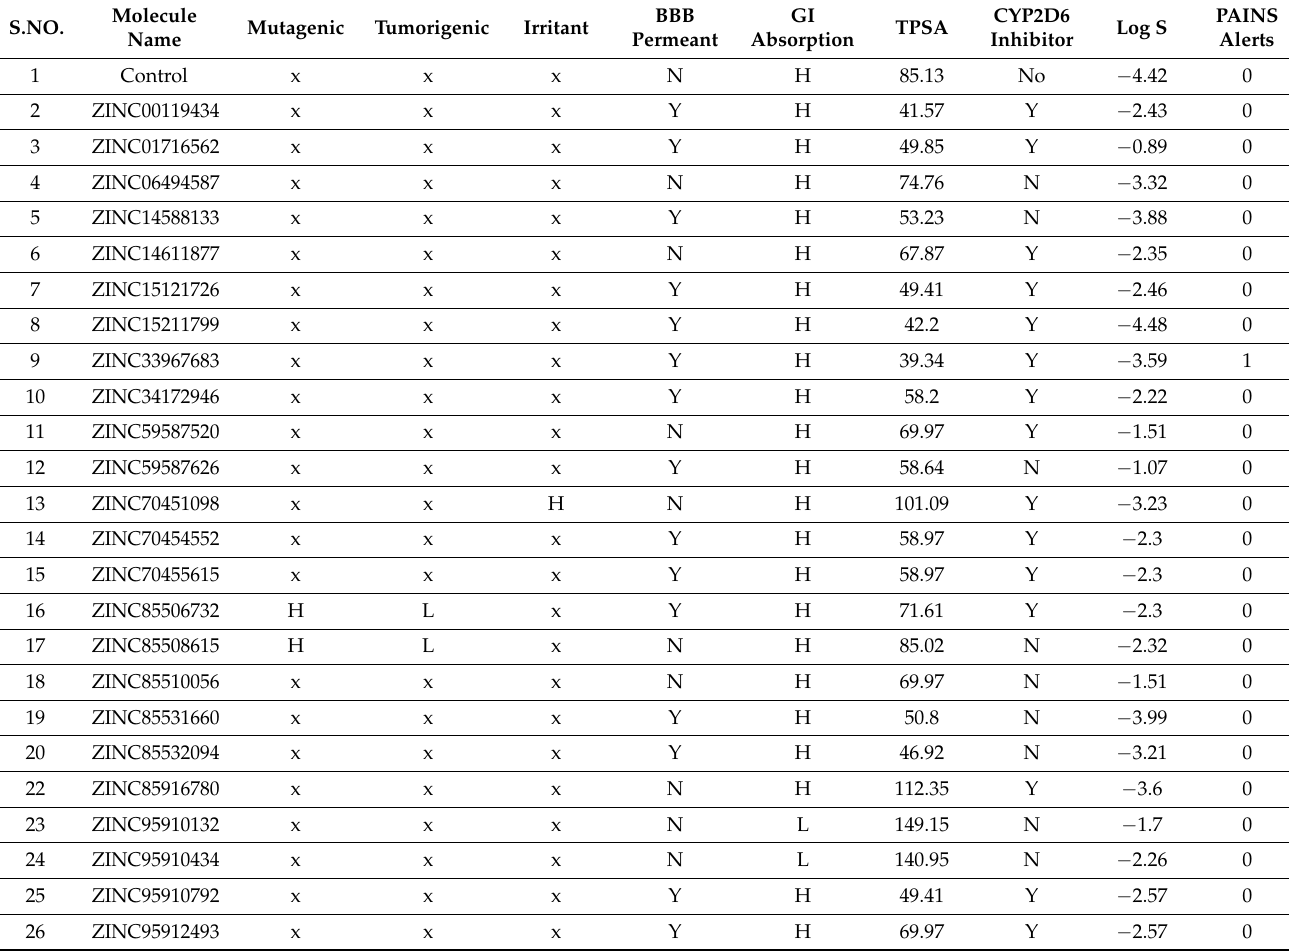
Table 2. ADMET prediction of control and top 24 screened